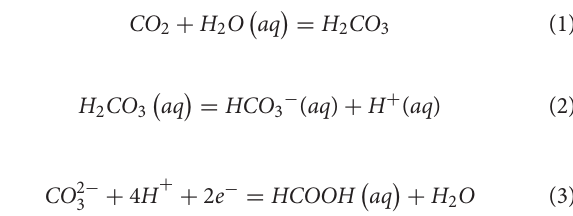
Frontiers in Chemistry |